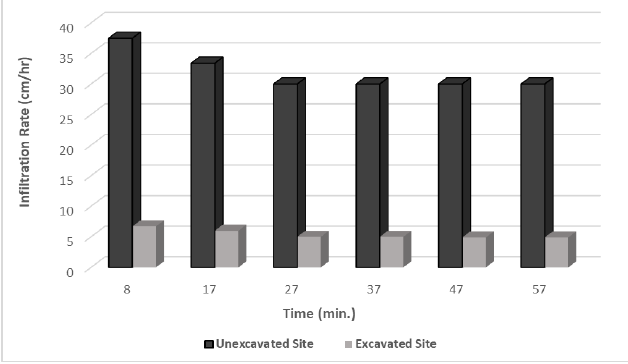
Figure 5: Bar chart of cumulative time and infiltration rate of the excavated and unexcavated